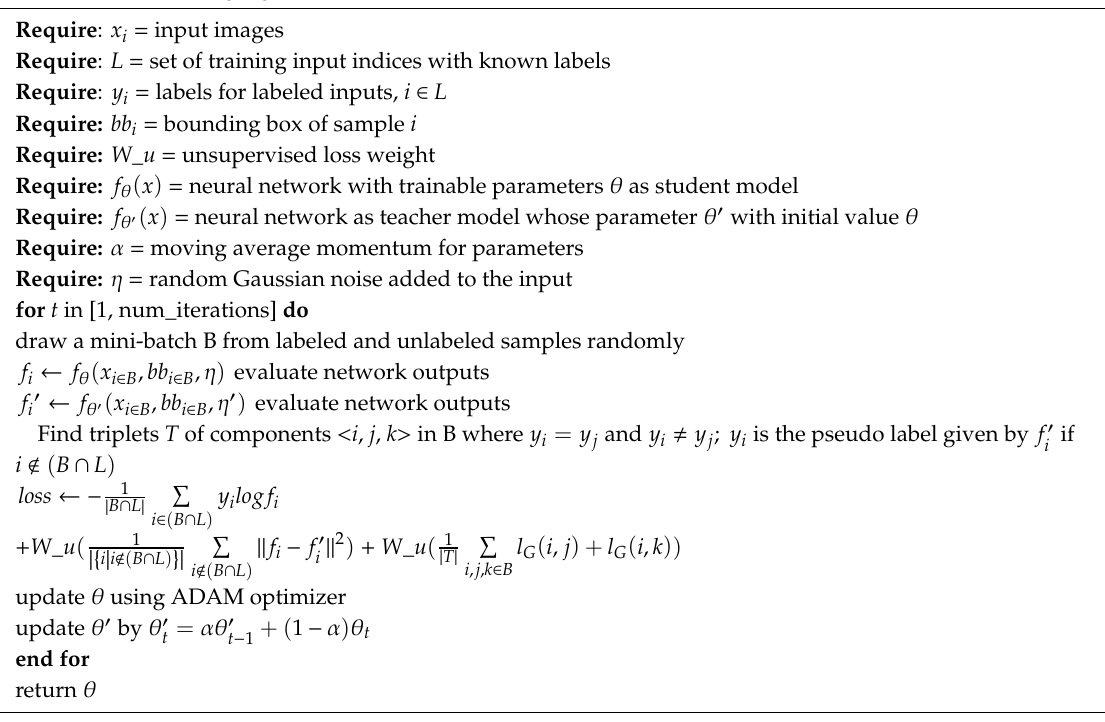
Algorithm 1. Training